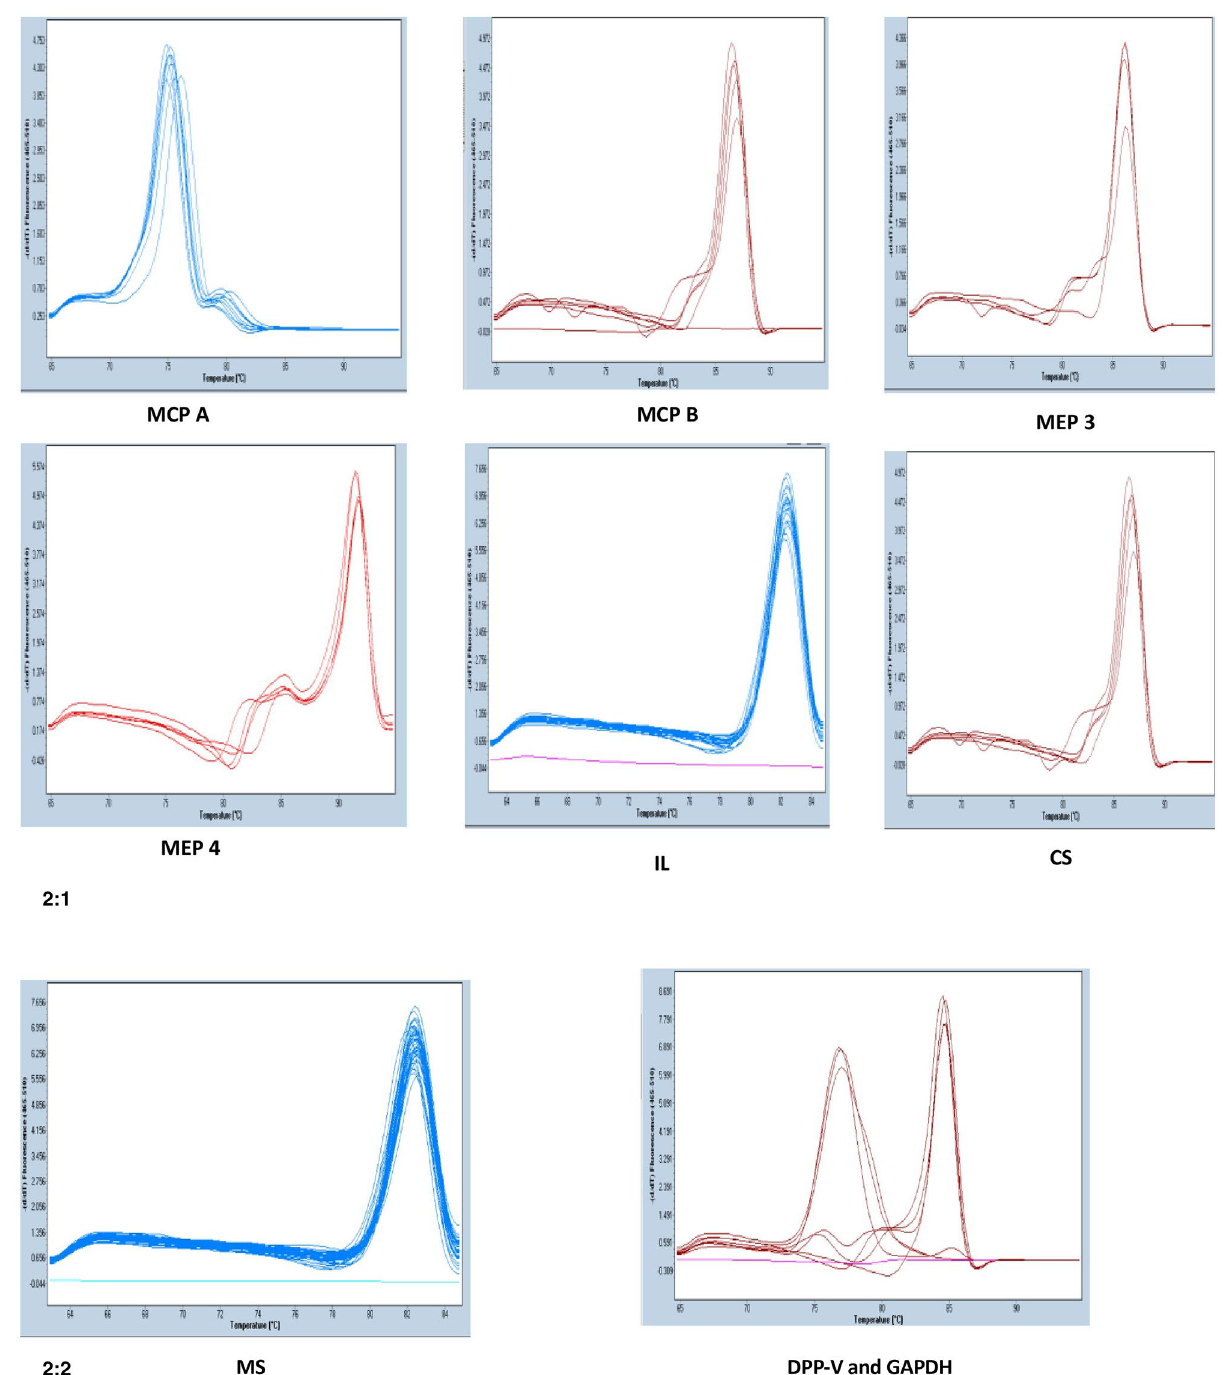
Figure 2. 2.1 Melting peak of MCP-A, MCP-B, MEP3, MEP4, IL and CS. 2.2 Melting peak of MS, DPPV and